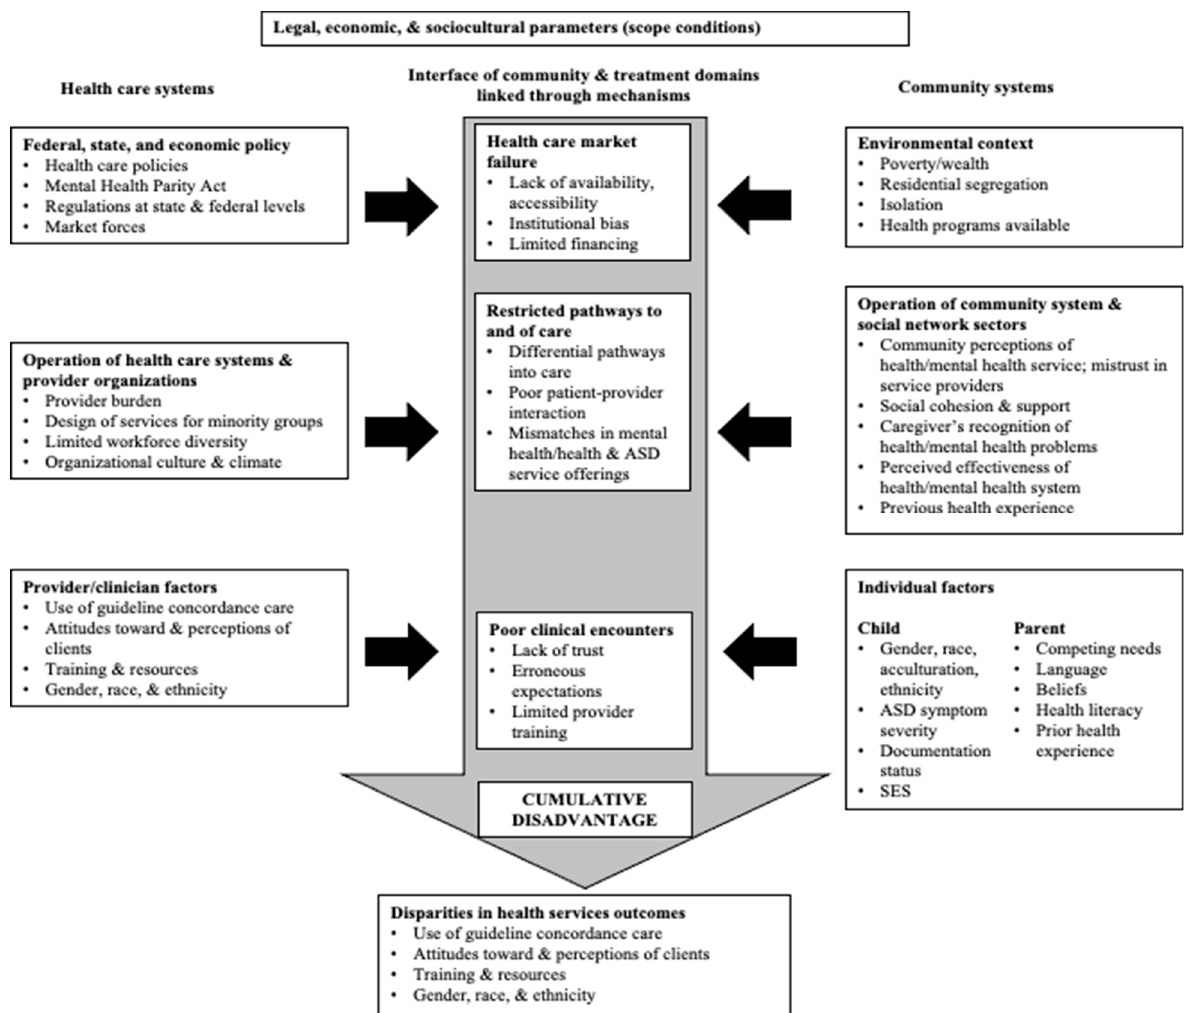
Figure 1. Modified Sociocultural Framework for ASD Health Services Disparities [15].